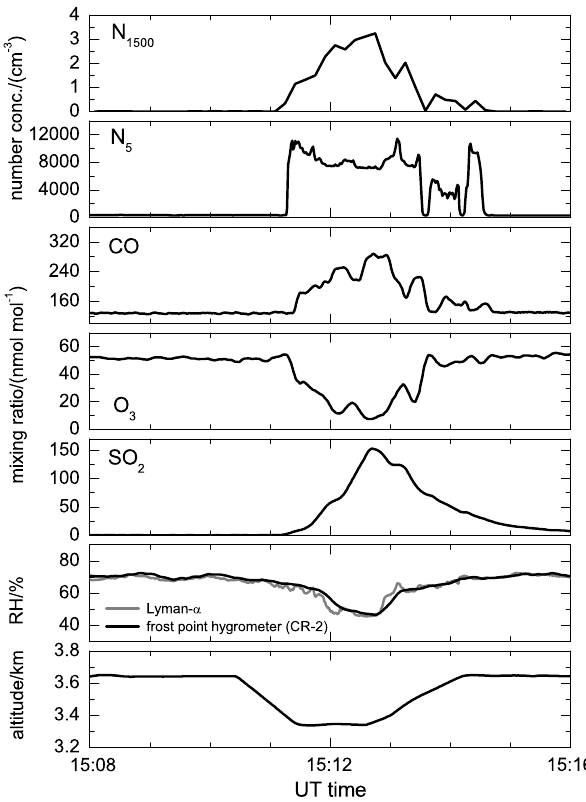
Fig. 13. Time series of aerosol number concentrations N in two size ranges ( > 1 . 5µm and > 5nm), trace gas mixing ratios of CO, O 3 , and SO 2 , relative humidity RH from the two hygrometers, and flight altitude during the measurements over the North Atlantic ver- sus time (h:min) on 2 May